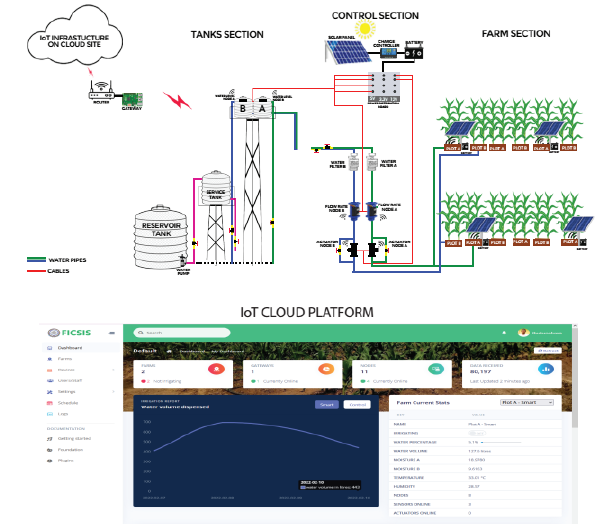
Figure 15. Developed IoT solution for optimal